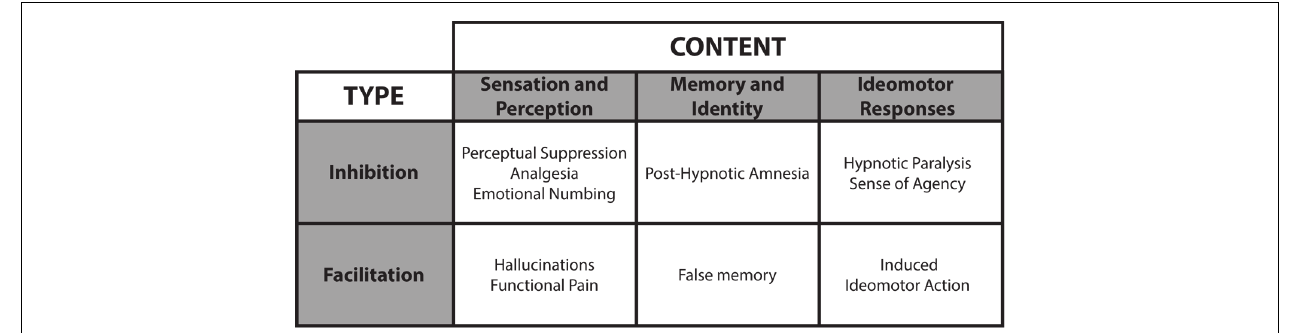
FIGURE 4 | Hypnotic suggestions divide as a function of type and content. These various hypnotic suggestions yield numerous hypnotic